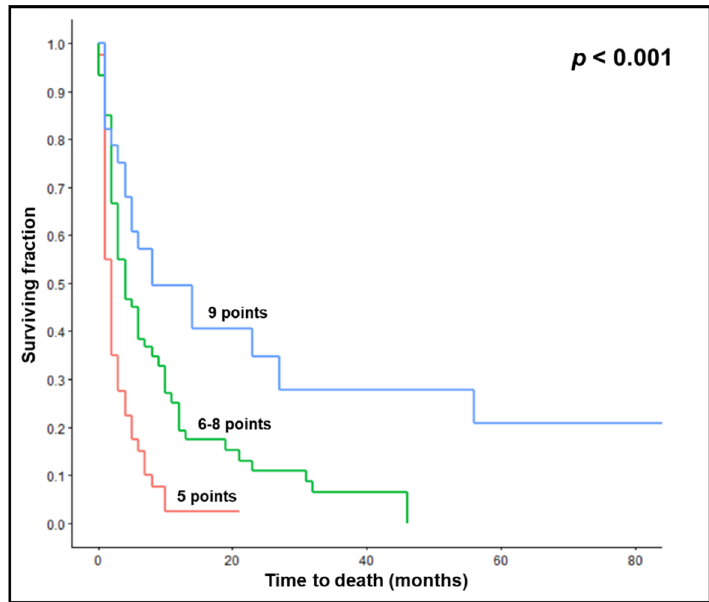
Figure 5. Model 1: Kaplan-Meier curves for the survival of the three groups (5, 6–8 and 9 points).